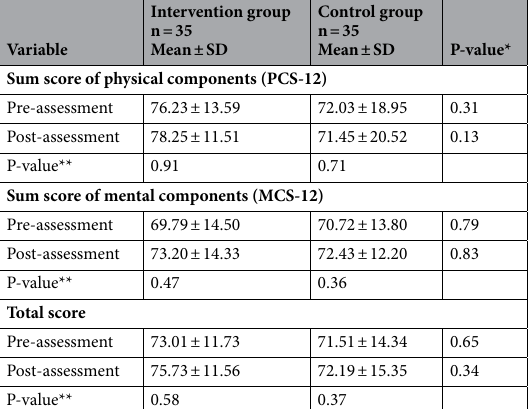
Table 3. Comparison of the scores of subgroups of QoL between intervention and control groups. QoL Quality of Life. *T-test was carried out for comparison of the groups. **Paired T-test was carried out for comparison of changes between the group.